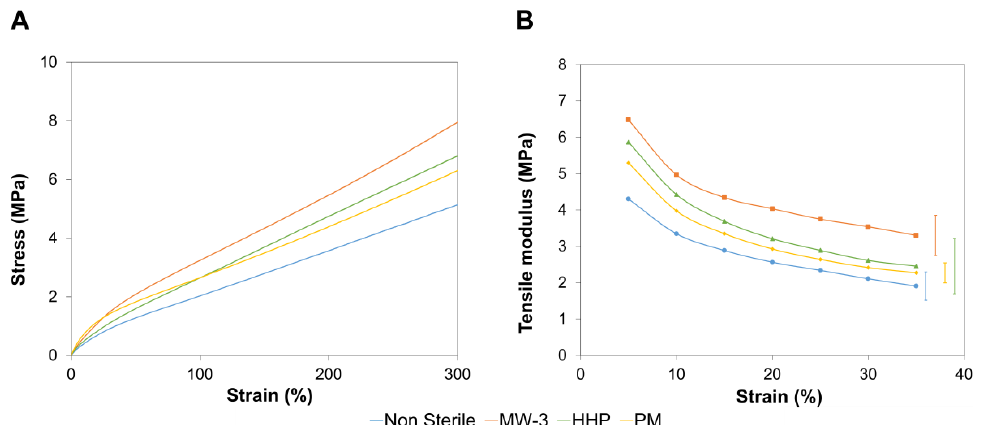
Figure 6. Typical tensile stress-strain curves ( A ), and tangent tensile modulus ( B ) for non-sterilised and sterilised PVA/PBO hydrogels. The error bars represent the mean ± standard deviations ( n =